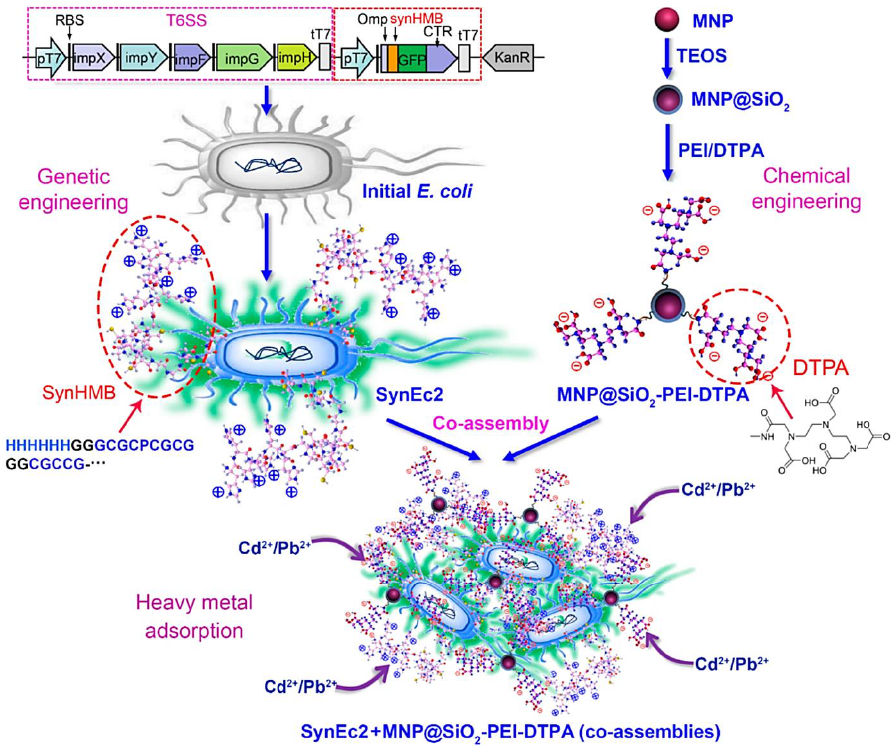
Figure 1. The preparative process of genetically engineered bacterial cells from E. coli to obtain co-assembles of magnetic NPs@SiO 2 -polyethylenimine (PEI)-diethylenetriaminepentaacetic acid (DTPA) for efficient removal of HMs. MNP: Magnetic NPs; TEOS: Tetraethyl orthosilicate. SiO 2 : Silicon dioxide. Adapted from Ref [67] with permission. Copyright 2020 American Chemical Society.